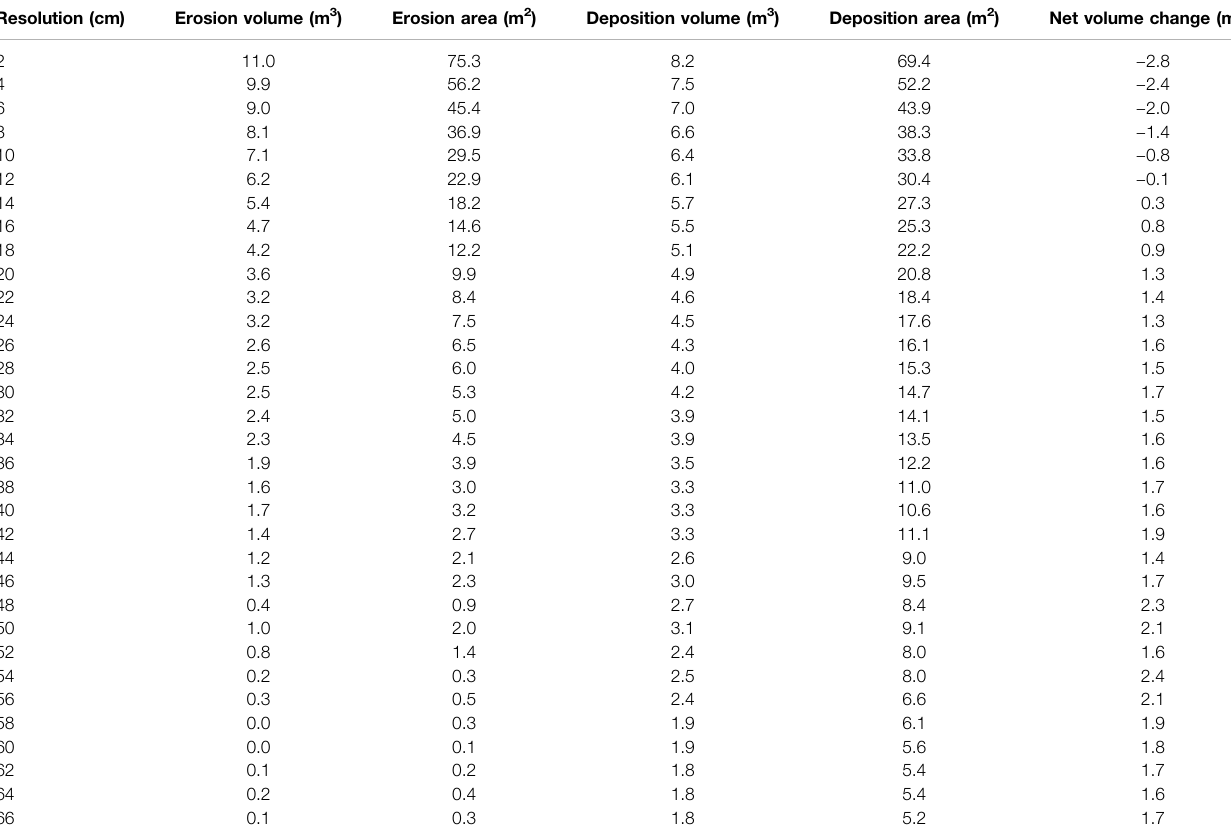
TABLE 2 | The estimated erosion, deposition, and net changes of the gully channel based on the Δ DEMs at different resolutions. Resolution